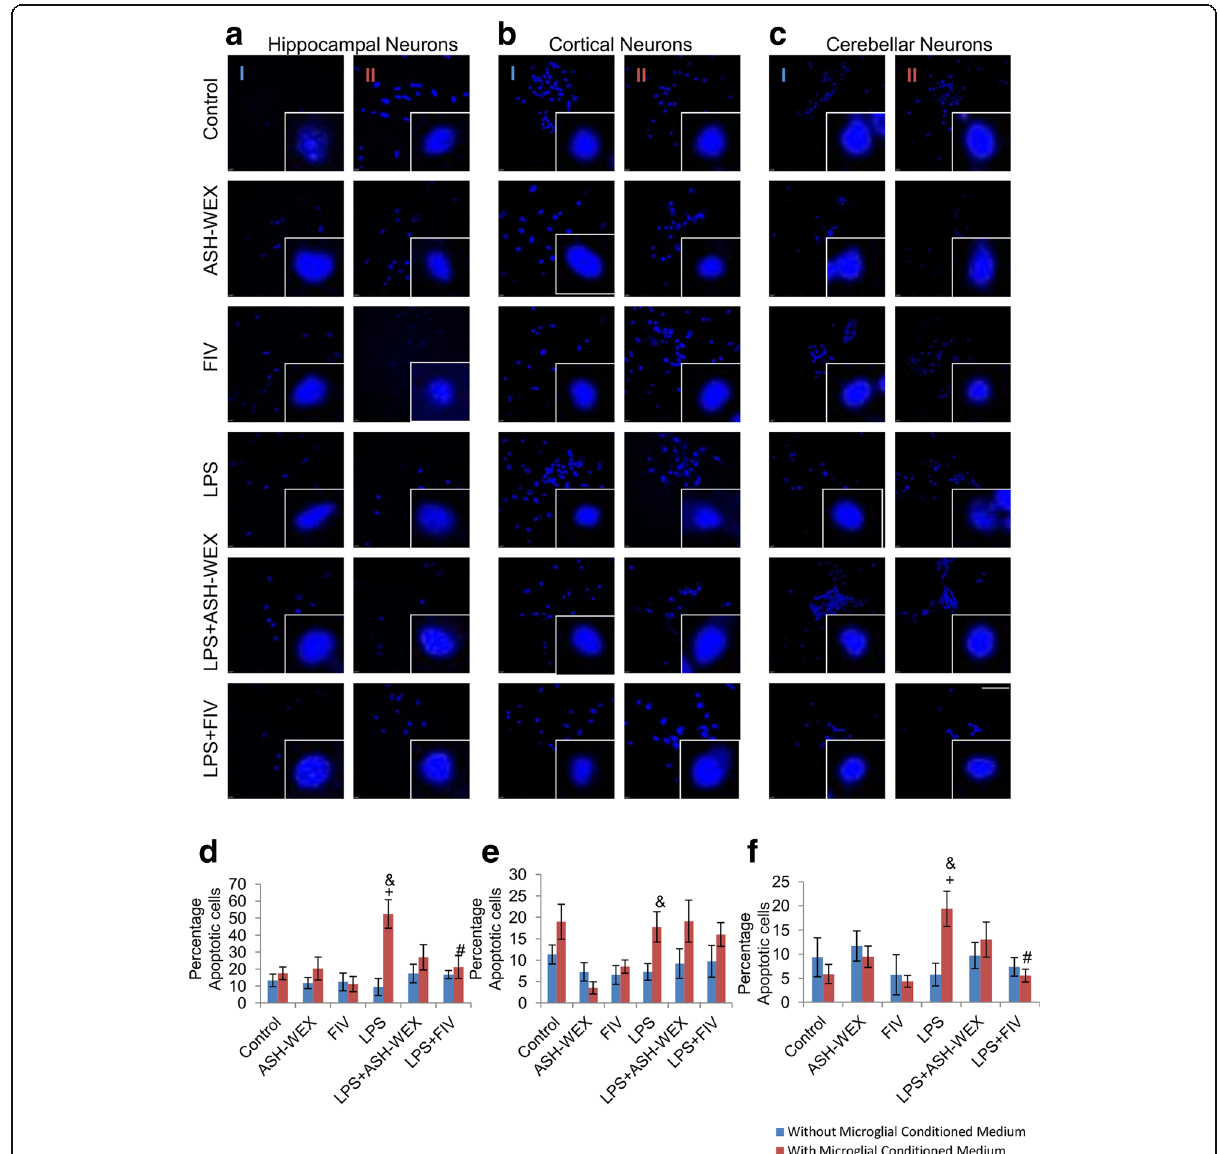
Fig. 6 ASH-WEX and FIV prevent apoptosis of neurons induced by LPS-induced neuroinflammation ( a , b , c ) Representative Confocal micrographs of DAPI immunostaining of primary cortical, hippocampal and cerebellar neurons respectively treated with (column I) ASH-WEX and FIV directly with or without activation with 100 ng/mL LPS, (column II) conditioned medium collected from LPS stimulated primary microglial cells with or without pretreatment with ASH-WEX and FIV for 24 h. ( d , e , f ) Histograms depicting percentage of apoptotic cells (Mean ± SEM) in primary hippocampal, cortical and cerebellar neuronal cultures, respectively, among different treatment groups calculated from three independent experiments. Cultures treated directly with ASH-WEX and FIV with or without activation with LPS were taken as 100%. * p ≤ 0.05 CM-Control versus CM-ASH-WEX alone, CM-FIV alone, CM-LPS + ASH-WEX and CM-LPS + FIV-treated groups. + p ≤ 0.05 CM-Control versus CM-LPS-treated group. # p ≤ 0.05 CM-LPS- versus CM-LPS + ASH-WEX- and CM-LPS + FIV-treated groups. & p ≤ 0.05 represents statistically significant difference between cultures treated with or without microglial conditioned medium corresponding to different treatment groups (one way ANOVA with Holm-Sidak post hoc test). Images were captured using Nikon A1R Laser Scanning Confocal Microscope at 60X magnification (Scale bar = 50 μ